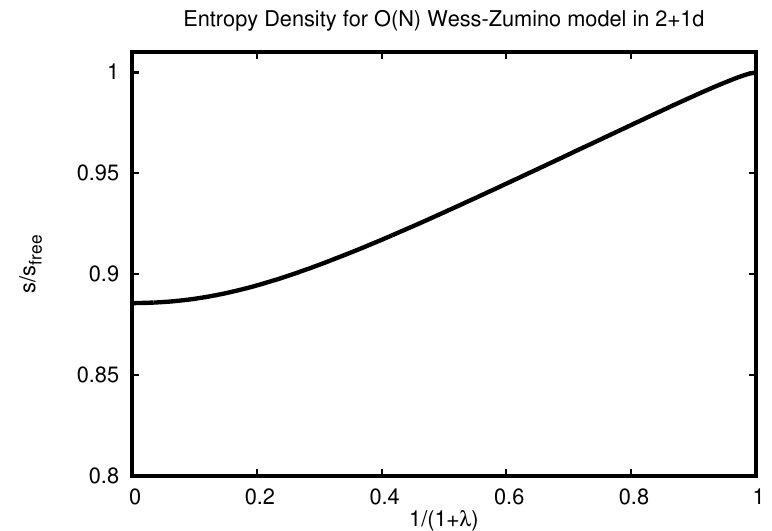
Figure 2 . Entropy density scaled by Stefan-Boltzmann limit in the O(N) Wess-Zumino model in 2+1d in the large N limit for all coupling values. Horizontal axis has been compacti(cid:12)ed in order to show the full range (cid:21) 2 [0 ; 1 ). See text for